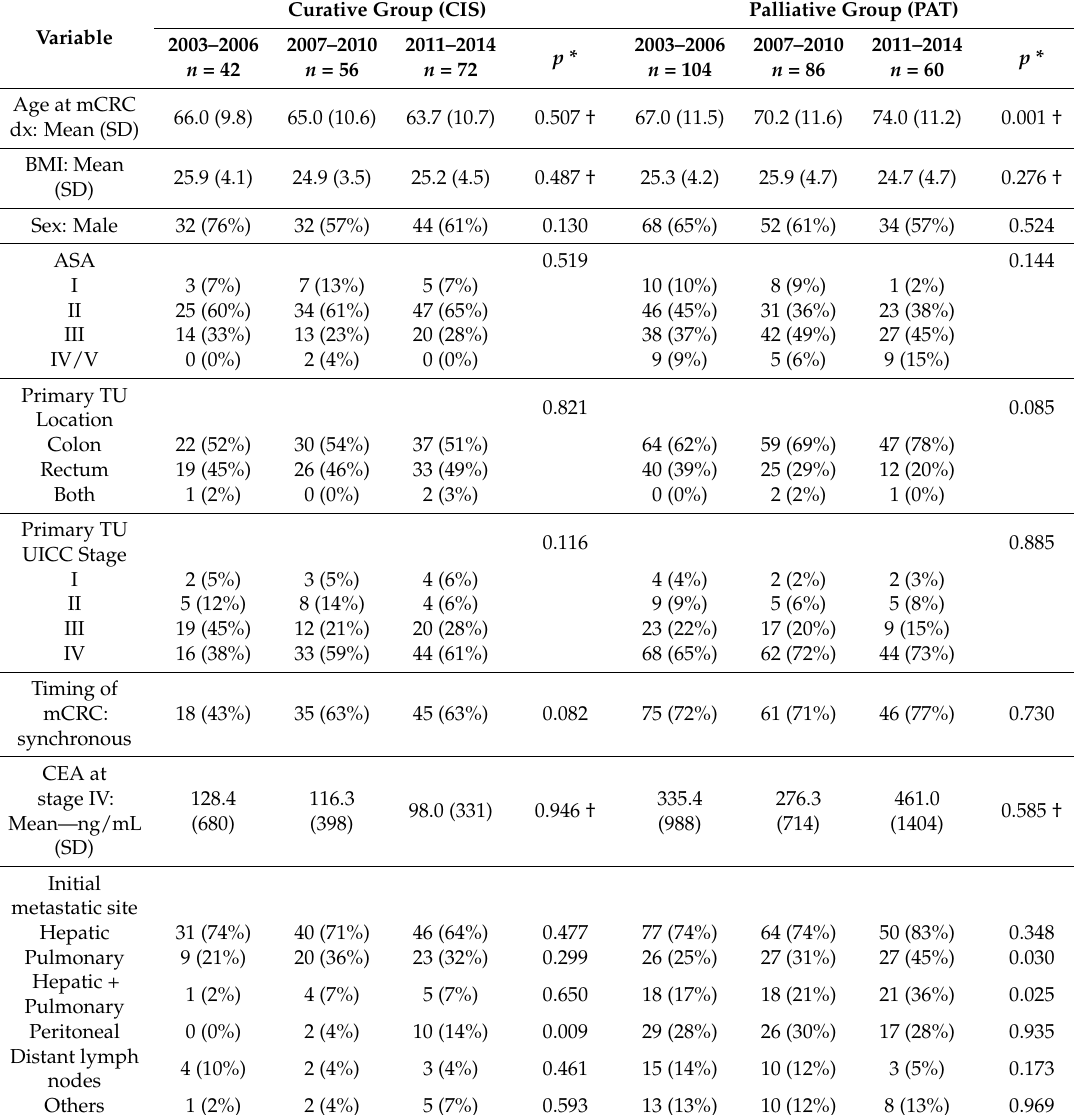
Table 1. Demographic, clinical and pathological characteristics of the CIS (curative intent surgery) and PAT (palliative therapy) subgroup during the three study periods.